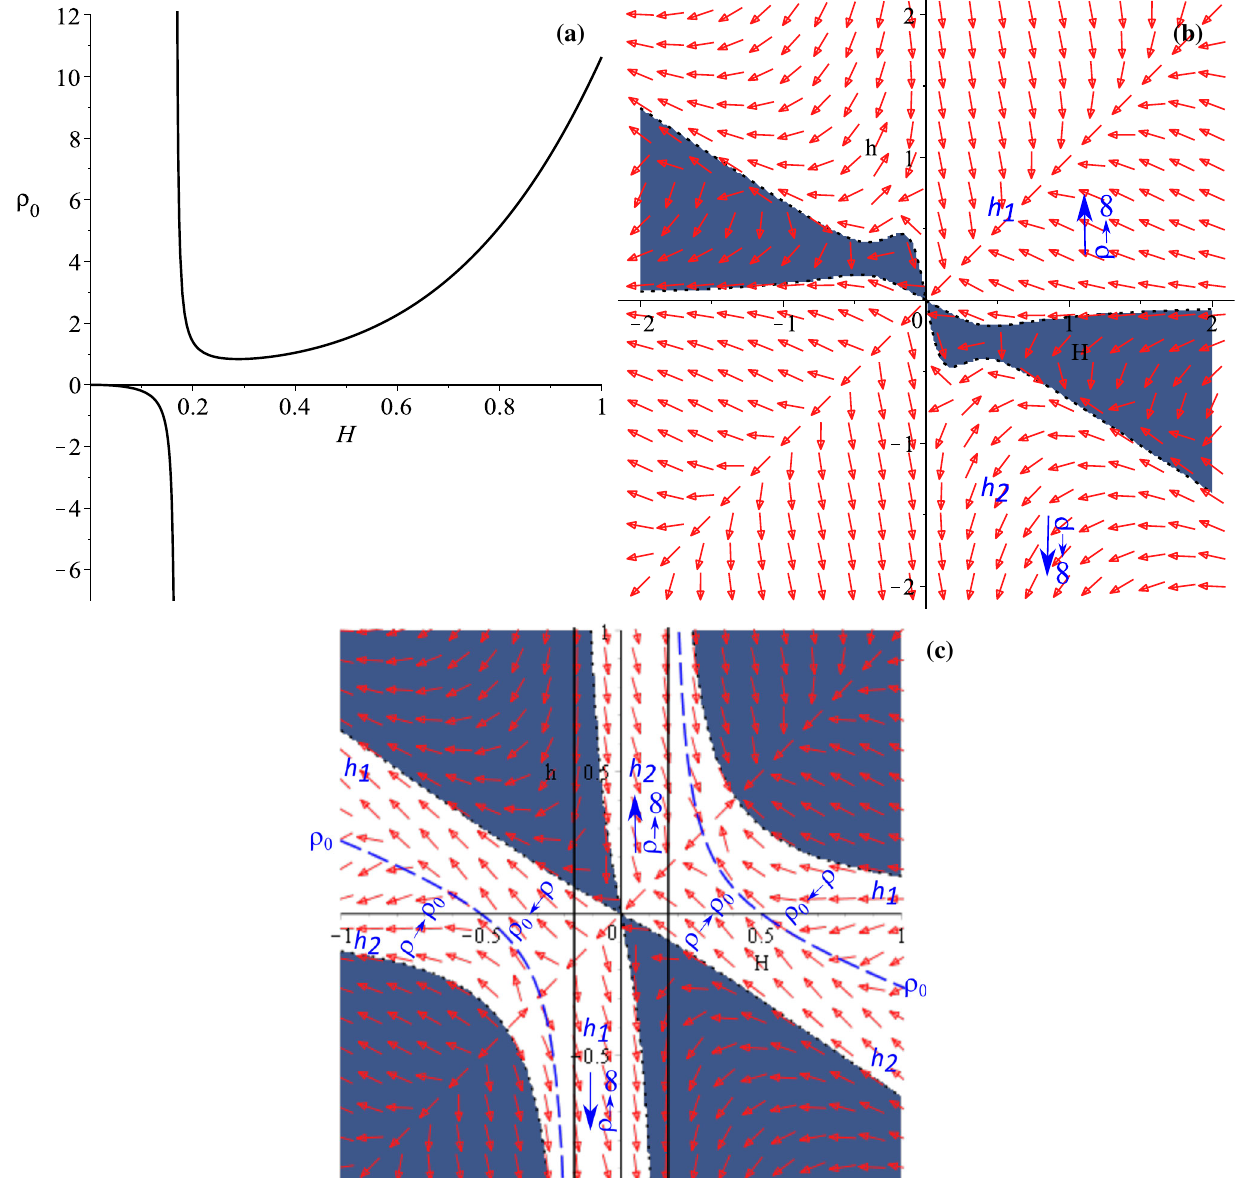
Fig. 7 Maximal density ρ 0 and its influence on the branches in D = 2: ρ 0 asafunctionof H on a ,infinitemaximaldensityinthe b , α < 0 case on c : no maximal density for H 2 < − 1 /( 36 α) and sepa-